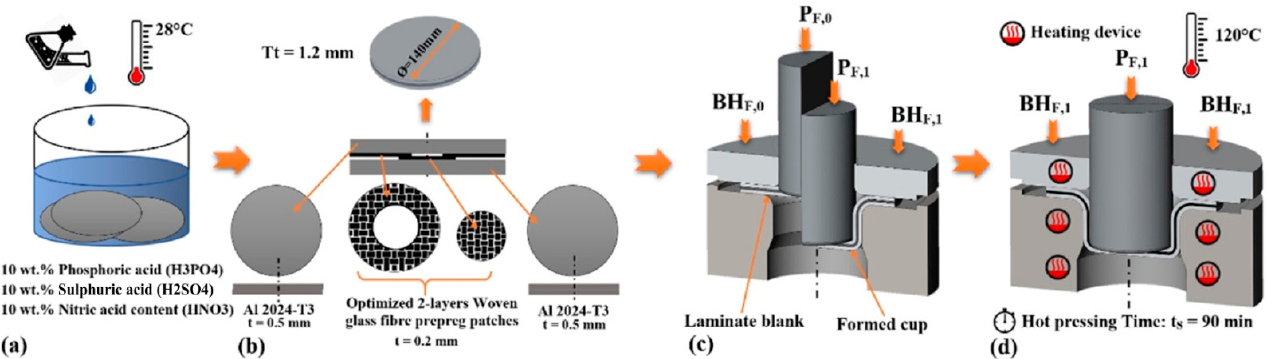
Figure 33. Preparation and forming of GLARE 2/1 using the new optimised process: ( a ) surface treatment of 2024-T3 sheets, ( b ) optimised 2/1 laminate assembly, ( c ) combined forming, and ( d ) hot pressing (reproduced with permission from [86]; copyright© 2021 Elsevier Ltd.).